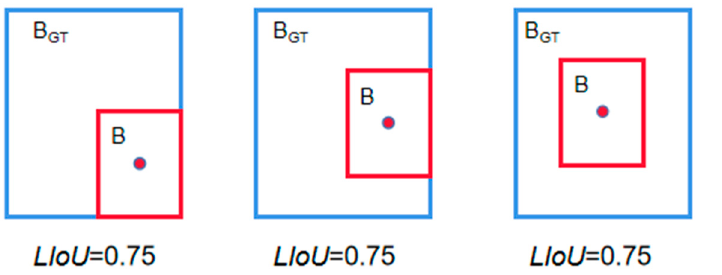
Figure 6. Limitations of IoU losses. Red rectangles represent prediction boxes, and blue rectangles represent reality boxes.